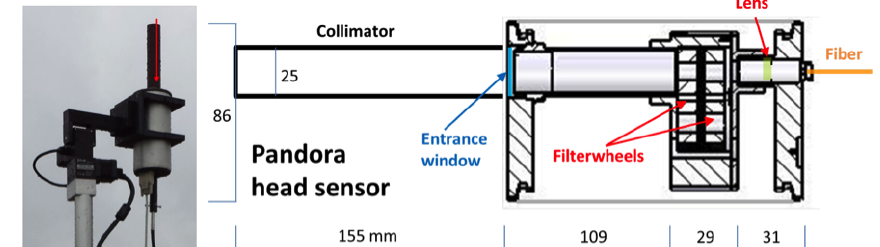
Figure 3. Pandora head sensor design (electronics boards are not